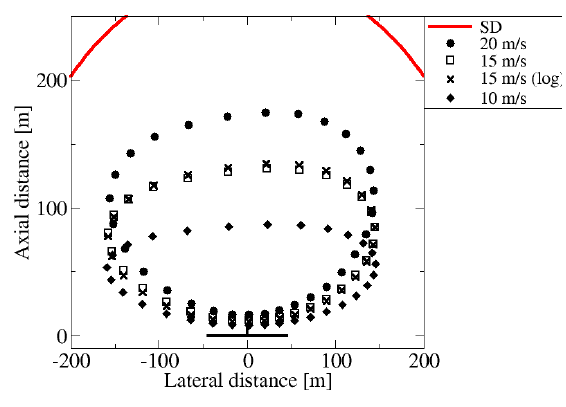
Figure 6. Impact positions for different wind velocity